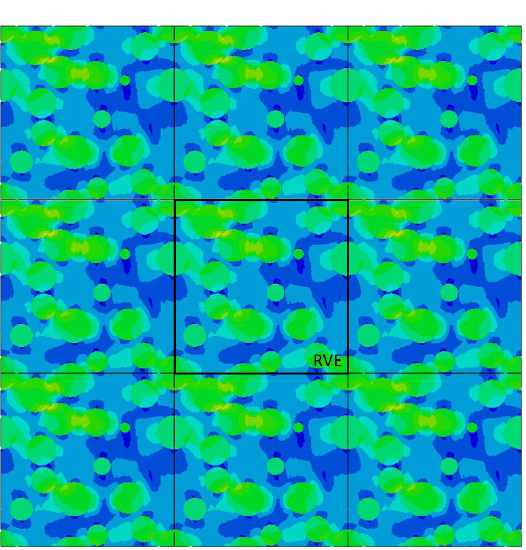
Figure 11. Periodic condition with continuity of stress field on left/ right and bottom/top sides.